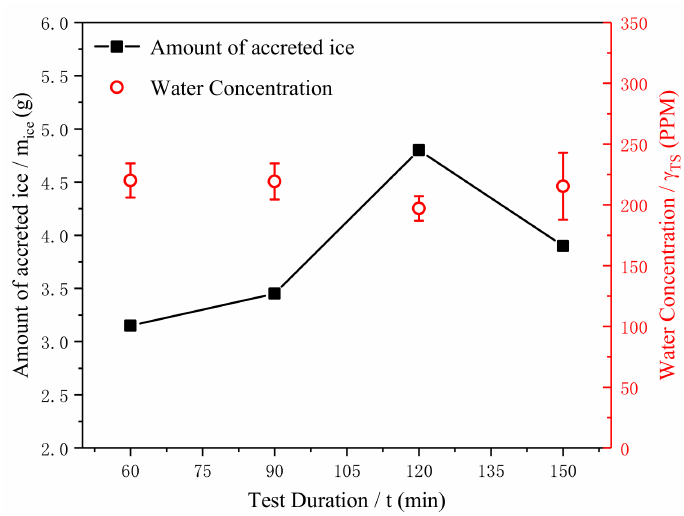
Figure 5. Mass of accreted ice in the upstream test section versus the test